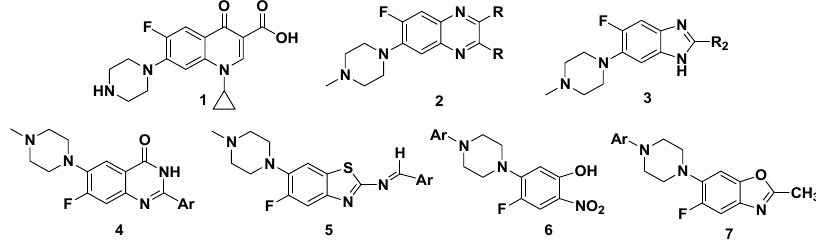
Figure 1. Examples of heterocyclic systems that contain fluorine and piperazine.